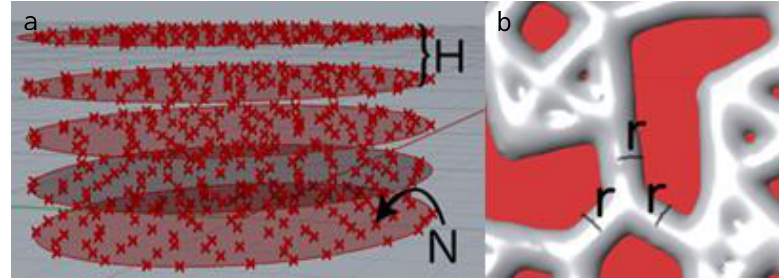
Figure 4. Parameters that define the porous structures: ( a ) parameters H and N, and ( b ) parameter r.